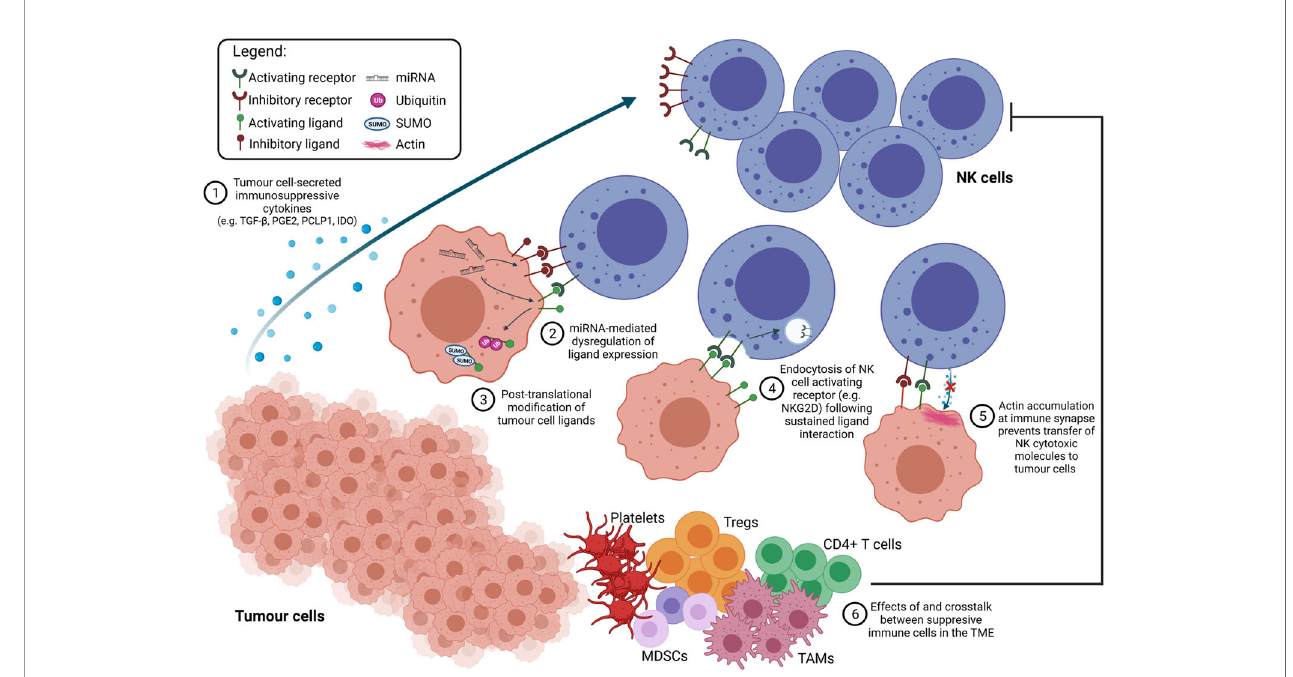
FIGURE 3 | TME factors suppress NK cell function. Tumour-intrinsic properties play a signi fi cant role in the downregulation of NK cytotoxicity through altering NK-cancer receptor-ligand interaction, which shifts the NK cell towards an inhibited/exhausted state. (1) The secretion of immunosuppressive cytokines modulates NK cell surface receptor expression. (2) Dysregulation of miRNA promotes the upregulation of inhibitory ligands and downregulation of activating ligands. (3) Upregulated post-translational modi fi cation processes (e.g., ubiquitination and SUMOylation) in tumour cells cause intracellular localisation of activating ligands, allowing tumour escape from NK cell recognition. (4) Chronic exposure to activating ligands on tumour cells promotes a feedback mechanism leading to endocytosis of NK cell activating receptors. (5) Altered cytoskeletal dynamics in tumours also contribute to tumour cell resistance to NK cell killing. Additionally, effective recognition of cancer by NK cells is hampered by (6) the multitude of other immune cells in the TME which not only downregulate NK function, but also aid tumour cells in evading NK cell